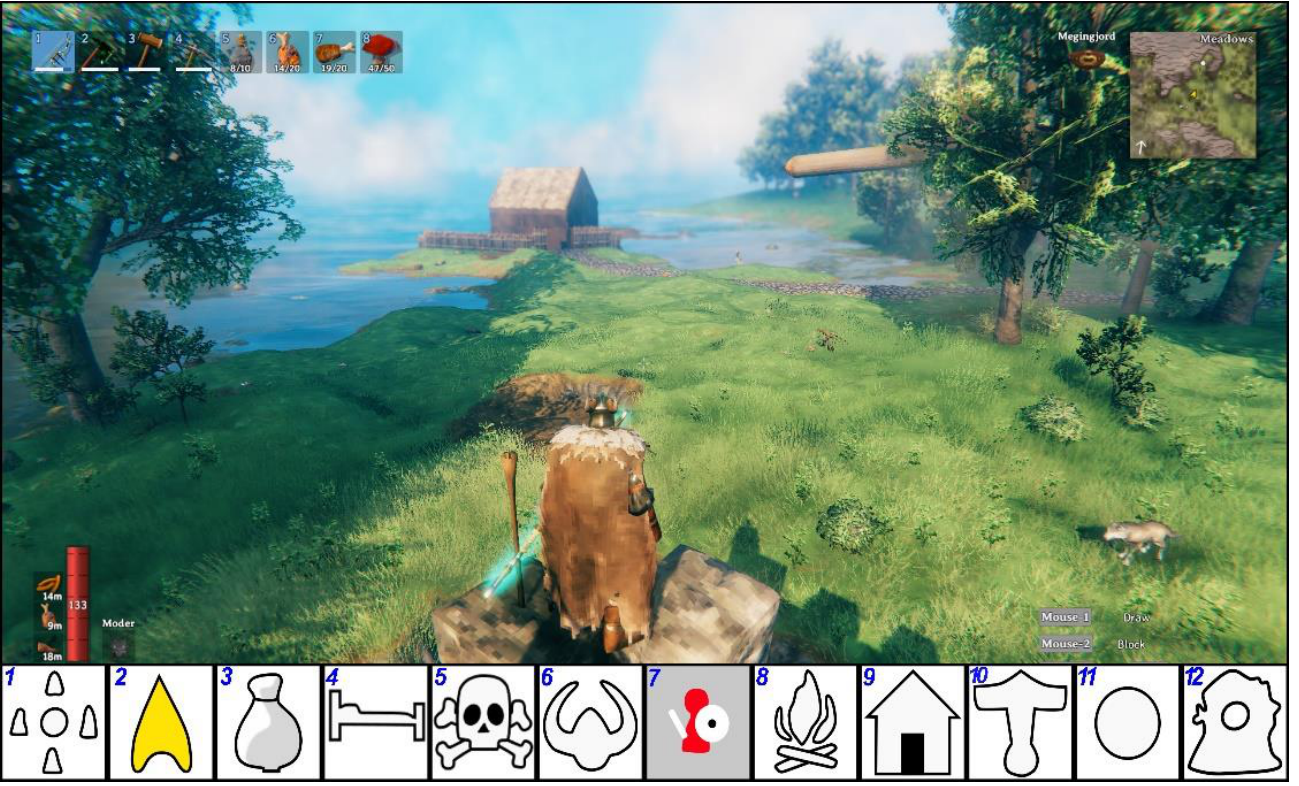
Figure 2. Screenshot from the game of Valheim and map symbols occurring on the map.